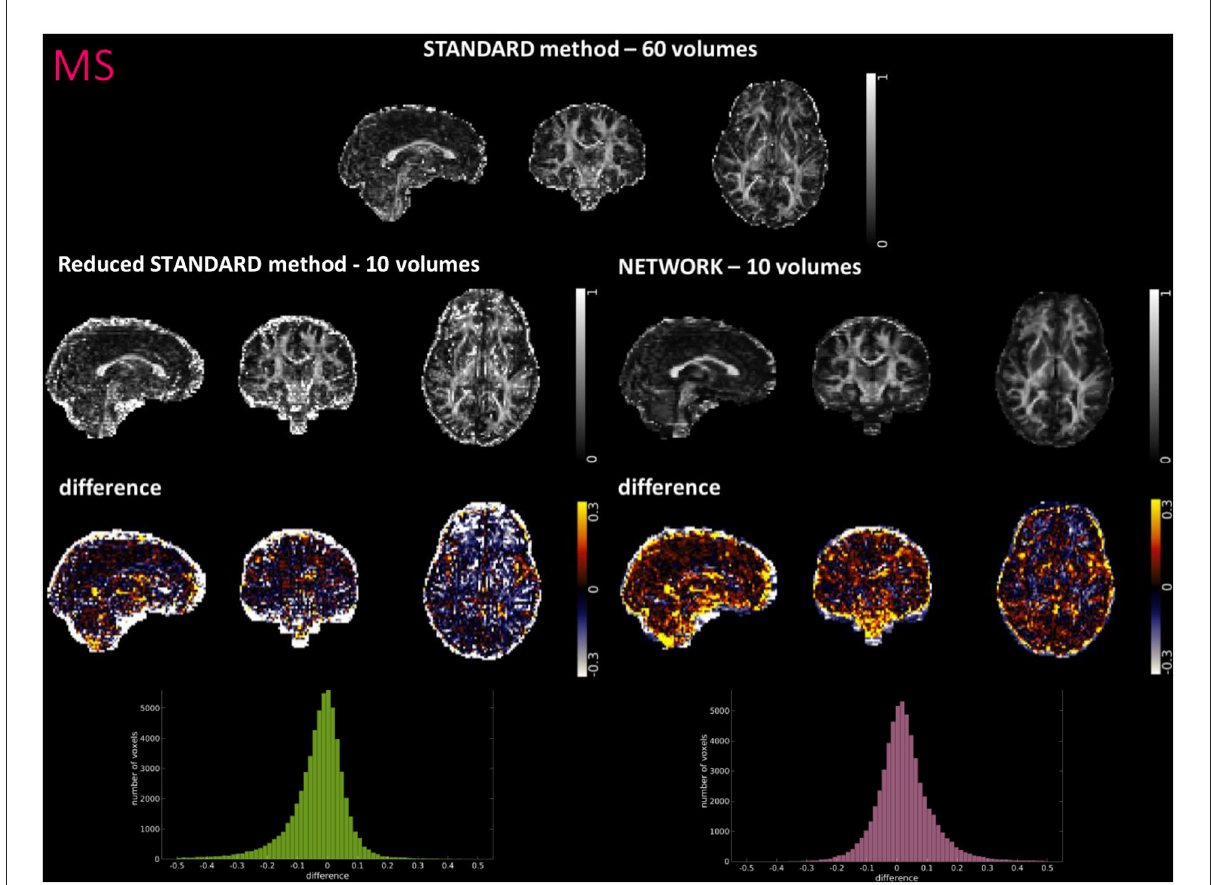
FIGURE6 For a random subject from multiple sclerosis (MS) study, each fractional anisotropy (FA) map is shown: the standard FA calculated with model fitting from all diffusion weighted (DW) volumes (STANDARD method − 60 volumes), the standard FA calculated with model fitting from a DW subset of 10 volumes (Reduced STANDARD method − 10 volumes), and the network FA from a DW subset of 10 volumes used as input (NETWORK − 10 volumes). The “difference” shows the voxel-wise difference between the (STANDARD method − 60 volumes) FA and either the (Reduced STANDARD methods − 10 volumes) FA or the (NETWORK − 10 volumes) FA maps. At the bottom, there is the histogram of the differences. All color bars have arbitrary units (a.